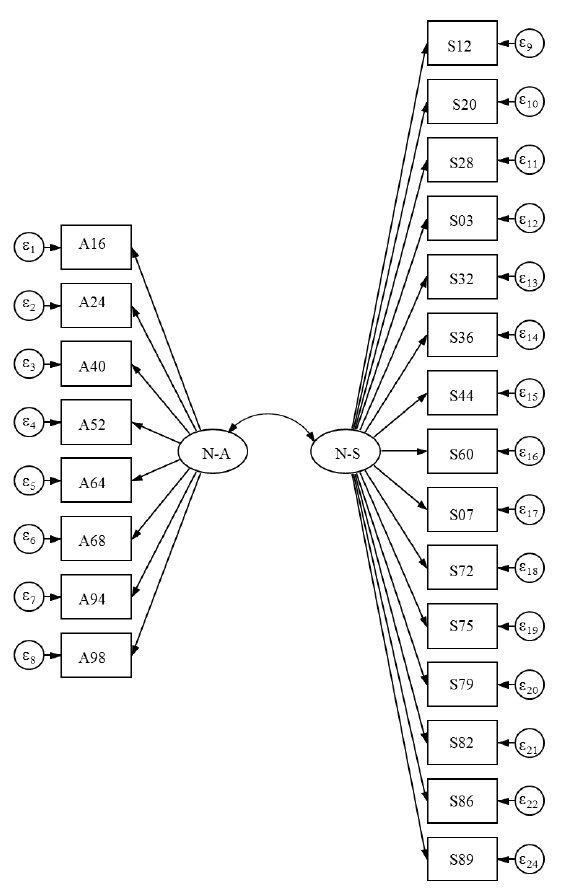
Figure 1. Two-factor model of EPQ N: sex-related (N-S) and sex-free (N-A) components. The item numbers refer to the original 100 item EPQ-R.